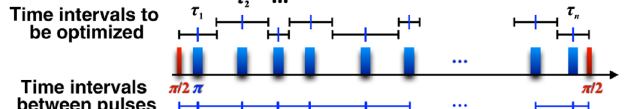
FIG. 6. Time interval τ j engineering. Optimization scheme of the n time intervals τ j of a measurement sequence with n pulses. Here, τ j ¼ ð t j þ t j Þ = 2 , where t j are the n þ 1 time þ 1 intervals between the π pulses, with j ¼ 0 ; … ; n , and t t 0 0 ¼ n þ 1 ¼